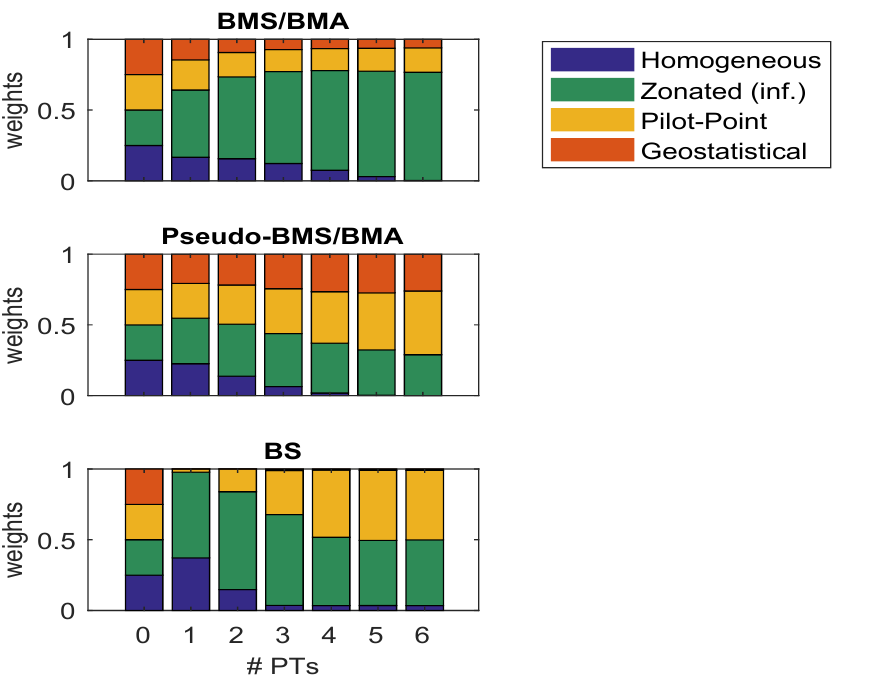
Figure 5. Expected model weights over growing data size (number of included pumping tests, # PTs) for the Quasi- M -closed setting, i.e., with data observed from the sandbox aquifer. Top row: BMS/BMA; center row: Pseudo-BMS/BMA; bottom row: Bayesian Stacking